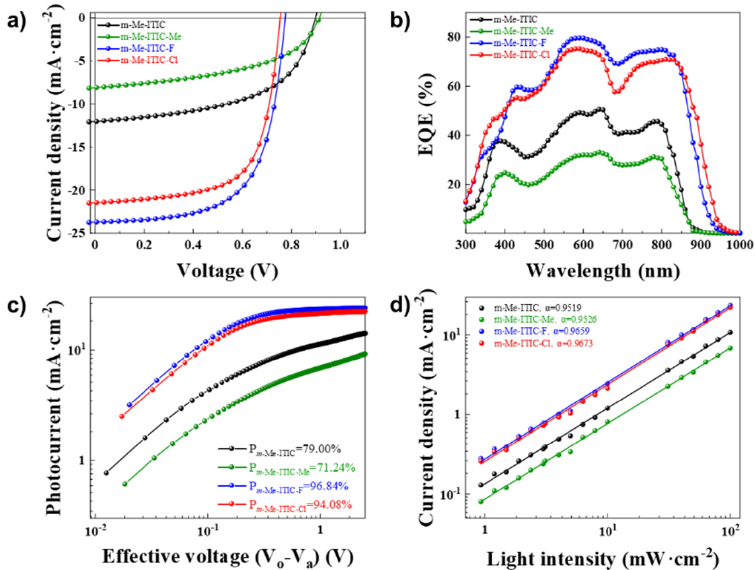
Figure 2. ( a ) J – V characteristics, ( b ) EQE spectra, ( c ) Photocurrent versus effective voltage, and ( d ) Current density versus light intensity of OPV cells based on PBDB-T: m-Me-ITIC, PBDB-T: m-Me- ITIC-Me, PBDB-T: m-Me-ITIC-F, and PBDB-T: